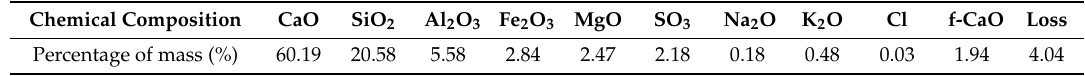
Table 1. Chemical composition of cement.